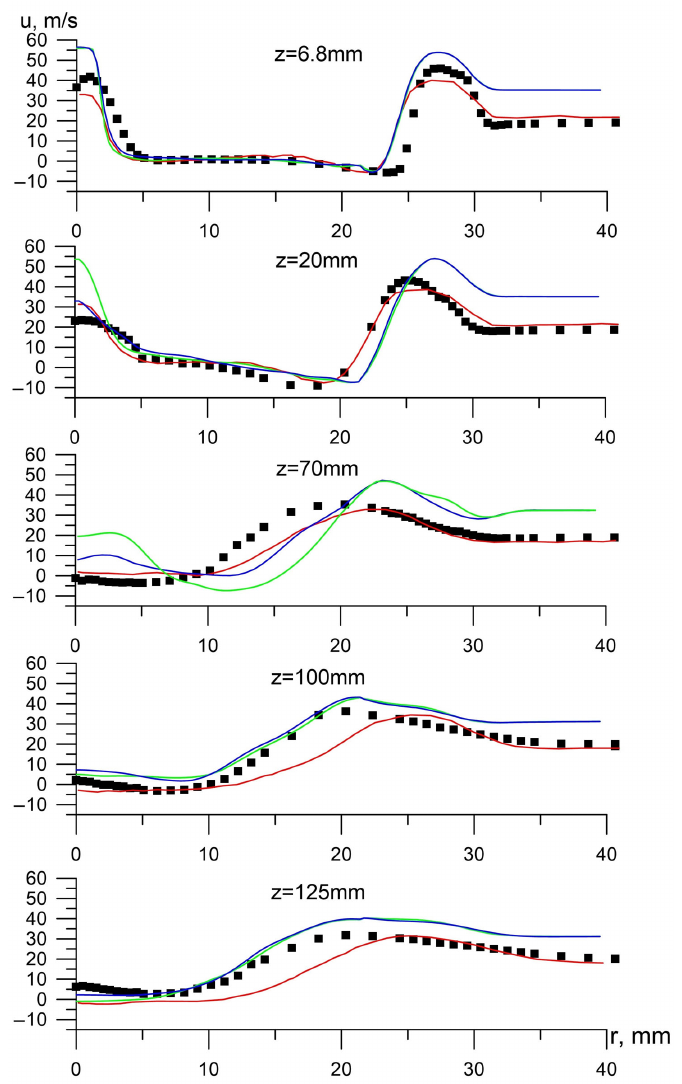
Figure 6. Comparison of the averaged axial velocity. Black squares denote experimental data; the red line denotes Hu, Zhou, and Luo simulations with Smagorinsky and PDF flamelet; the green line represents our simulation with the Smagorinsky model; and the blue line represents our simulation with the DSM model.